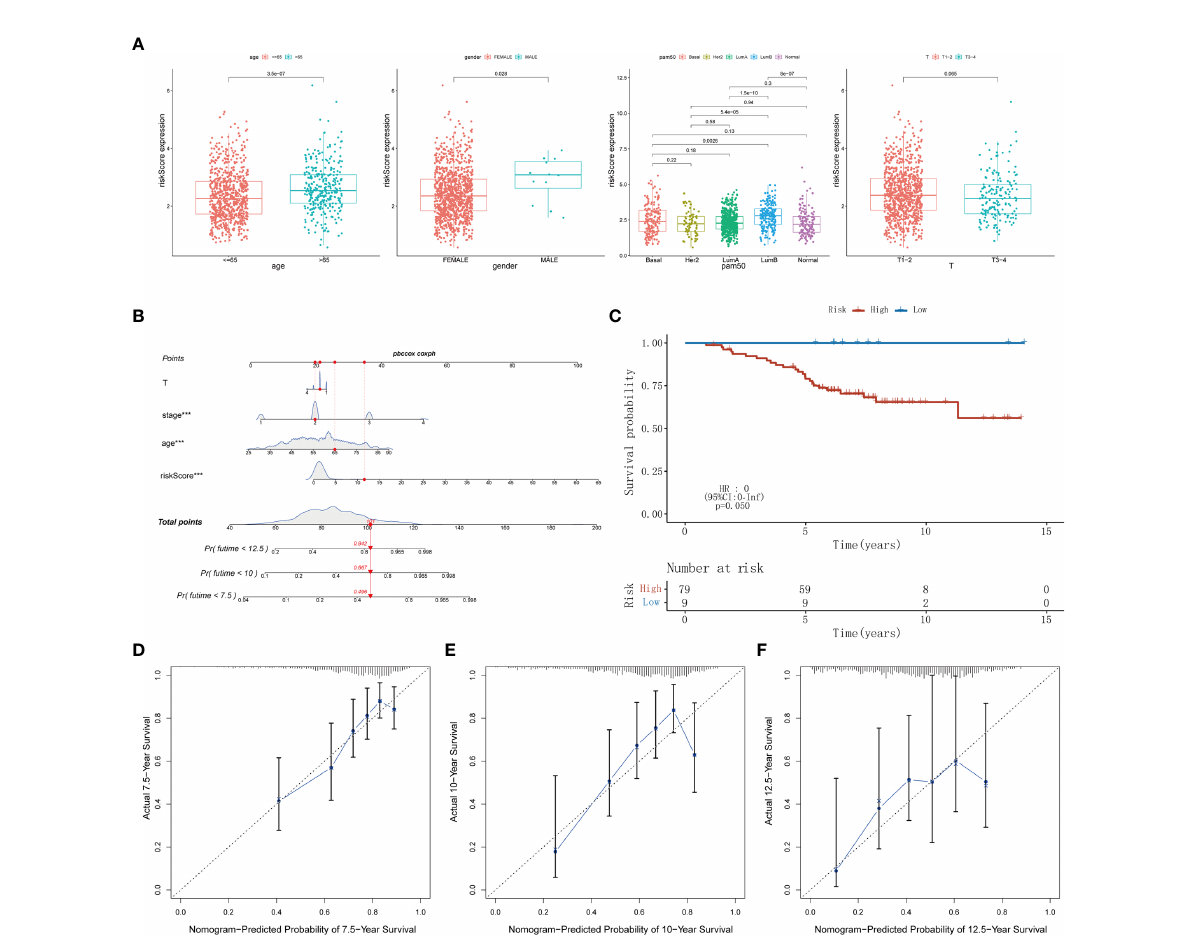
FIGURE 7 (A) The difference of risk score in clinicopathological classi fi cation including age, gender, PAM50 intrinsic subtypes and T stage. (B) Nomogram based on risk score, age, stage, T stage constructed to predict the 7.5-, 10-, and 12.5-year survival for BRCA patients. (C) Kaplan – Meier curves for BRCA patients to validate predictive value of Pyro-GPS risk model in the GSE20711 cohort. (D-F) Calibration plots of the nomogram for predicting the survival probability of OS at 7.5, 10, and 12.5 years. BRCA, breast cancer; Pyro-GPS, pyroptosis-related genes prognostic signature; ***p <